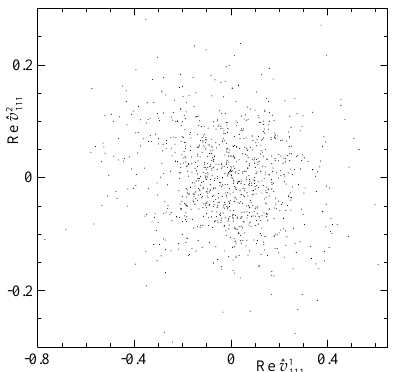
= 0 on the plane (Re ˆ v 1 222